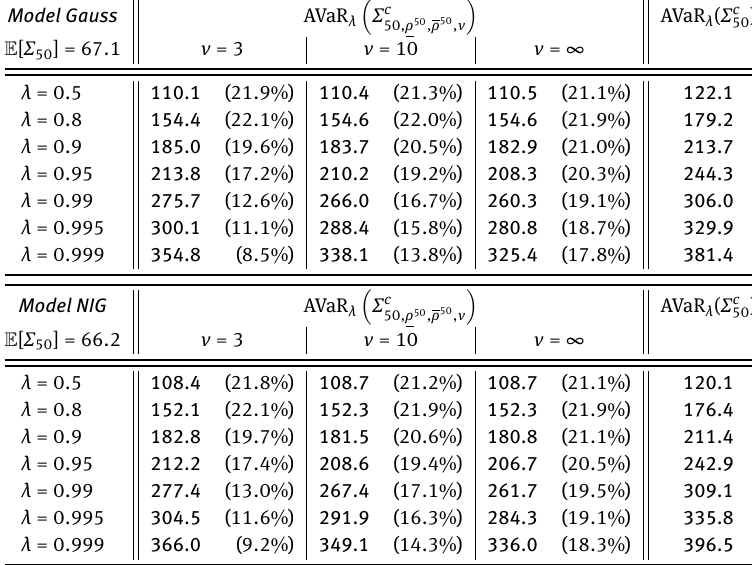
) for ) with the standard comonotonic risk bound AVaR ( Σ c 50 λ 50, ρ 50 , ρ 50 , ν )− E [ Σ 50 ])/(AVaR ( Σ c )− E [ Σ 50 ]) is displayed 50 λ 50, ρ 50 , ρ 50 , ν